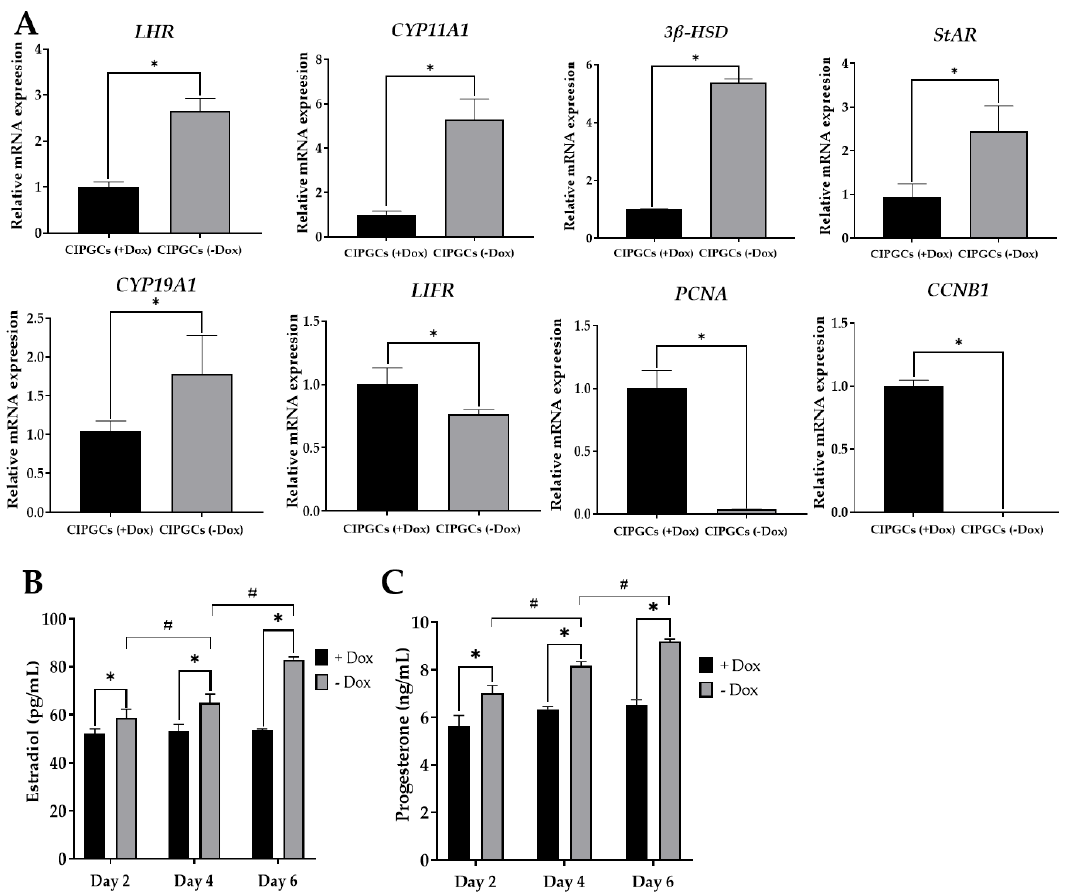
Figure 6. Expression of granulosa markers in the GC line when cultured in the presence and absence of Dox. ( A ) The mRNA expression of LHR , CYP11A1 , 3 β -HSD , StAR , LIFR , PCNA , and CCNB1 by quantitative PCR after culturing for six days with or without Dox. Estradiol ( B ) and progesterone ( C ) detection by ELISA detection ( n = 6). LHR , luteinizing hormone receptor CYP11A1 , cytochrome P450 family 11 subfamily A member 1; 3 β -HSD , 3 β -hydroxysteroid dehydrogenase; StAR , steroidogenic acute regulatory protein; CYP19A1 , cytochrome P450 family 19 subfamily a member 1; LIFR , leukemia inhibitory factor receptor; PCNA , proliferating cell nuclear antigen; CCNB1 , cyclin B1; FSH, follicular stimulating hormone; LH, luteinizing hormone. The experiment was repeated three times. * stands for significant di ff erence between + Dox and –Dox group at specific day ( p < 0.05). # stands for significant di ff erence from three time points in the –Dox group ( p < 0.05).